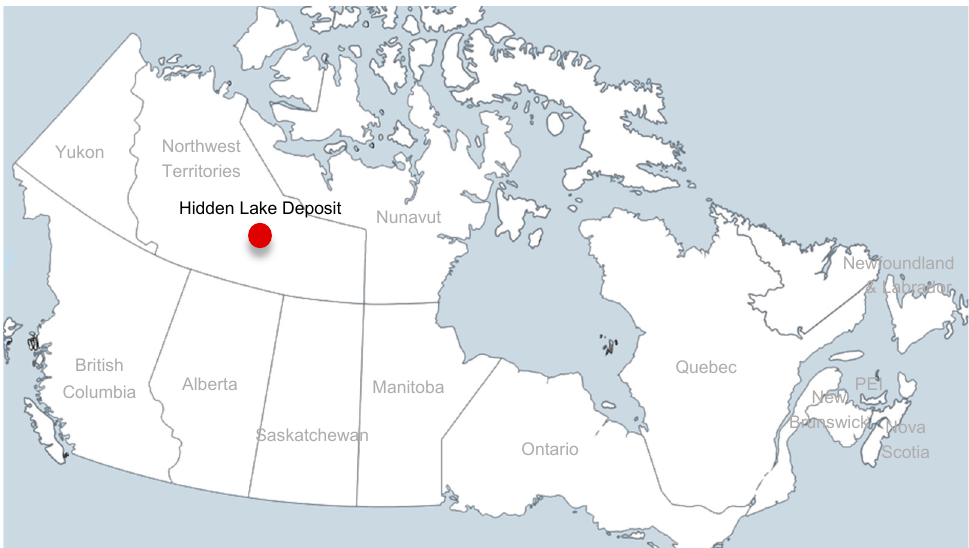
Figure 1. Location of the Hidden Lake lithium deposit in Northwest Territories, Canada.